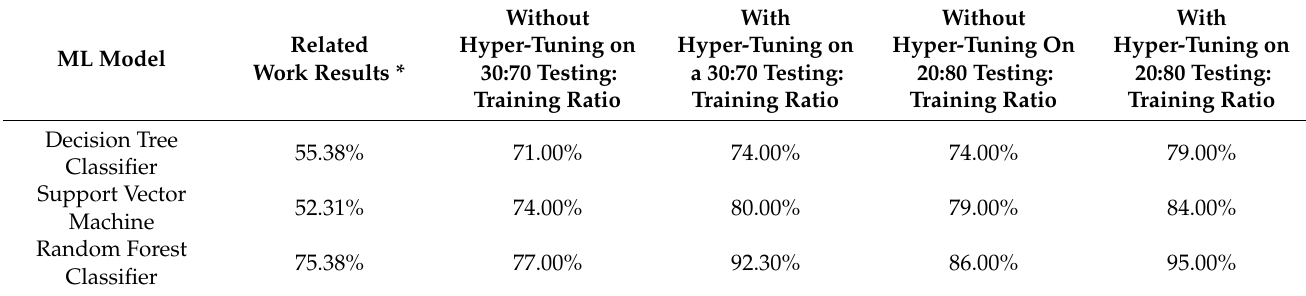
Table 9. Comparison of accuracy results between the related work [3] and this